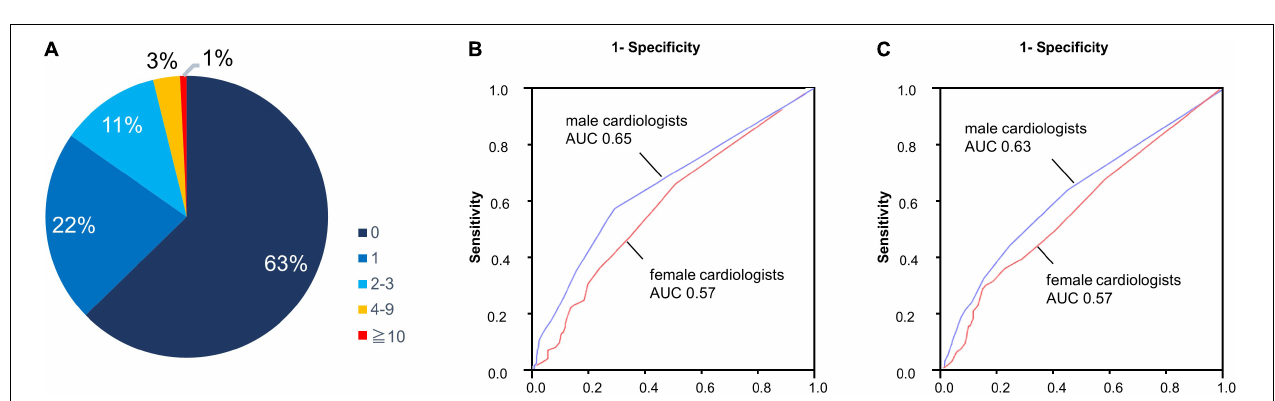
FIGURE 3 | Number of female cardiovascular specialists belonging to each hospital. (A) Number of female cardiovascular specialists belonging to each hospital in all registered hospitals ( n = 1408). (B) Acceptance of chairperson by the number of female cardiovascular specialists belonging to each hospital: Japanese session. (C) Acceptance of chairperson by the number of female cardiovascular specialists belonging to each hospital: English session.